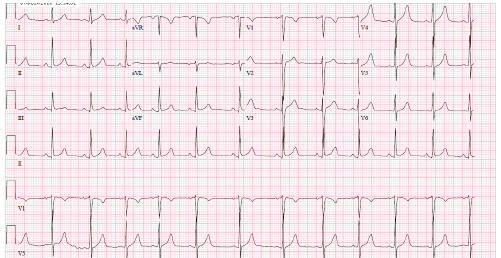
Figure 2: EKG on admission shows coarse atrial fi brillation with a slow ventricular response. Whereas the tracings in the precordial leads to appear organized, the tracing in lead II suggests coarse atrial fi brillation.